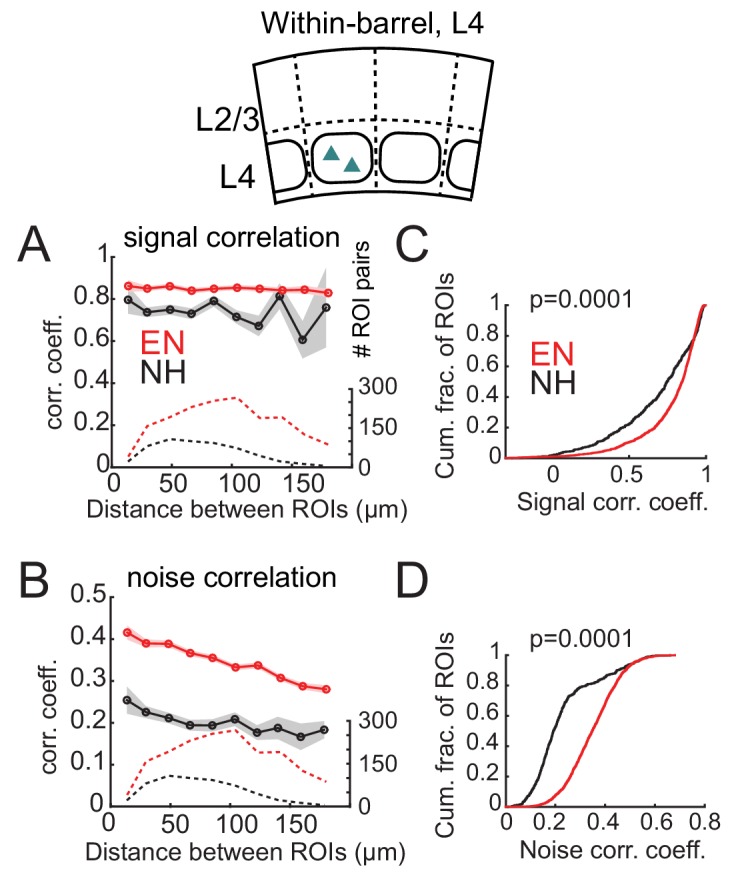
Enrichment increases signal and noise correlations within L4 barrels.(A) Mean signal correlation across responsive L4 cell pairs as a function of inter-ROI distance, for cell pairs within a column. Conventions as in Figure 6A. Inset, schematic of cell locations. (B) Mean noise correlation across within-column pairs, plotted as in (A). (C–D) Cumulative distribution of signal correlations (C) or noise correlations (D) for within-barrel ROI pairs in L4.